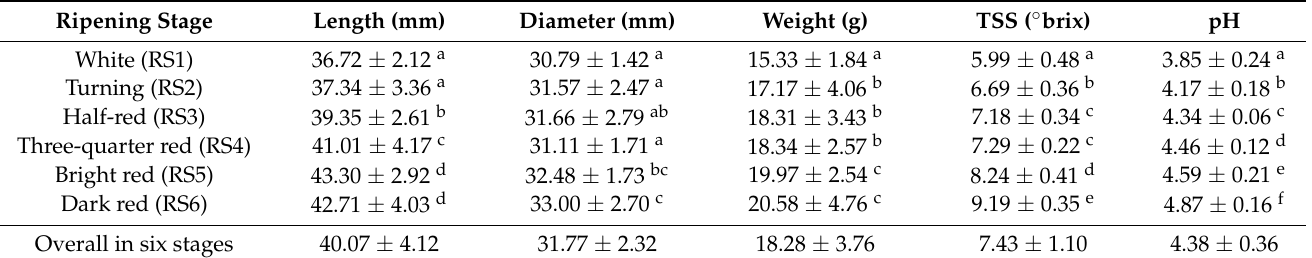
Table 1. Biometrical characteristics, total soluble solids (TSS) and pH in strawberry fruits at six stages of